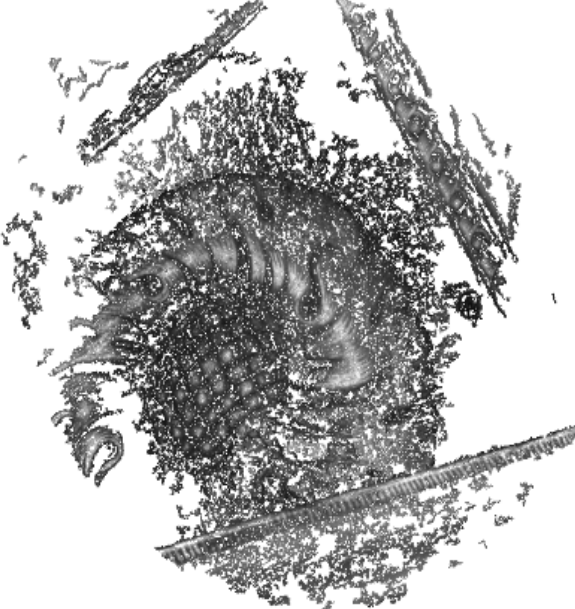
Figure 9. Images were corrected for geometry and radiometry and used in the process of 3D point generation. Level 1 of image pyramid was used for 3D